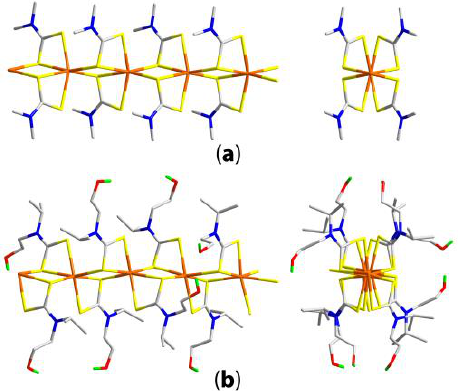
Figure 13. Side- and end-on views of one-dimensional chains in the crystals of ( a ) [Cd(S 2 CNMe) 2 ] n ( 135 ) and ( b ) {Cd[S 2 CN(i-Pr)CH 2 CH 2 OH] 2 } n ( 141 ). Additional colour code: hydrogen, green.